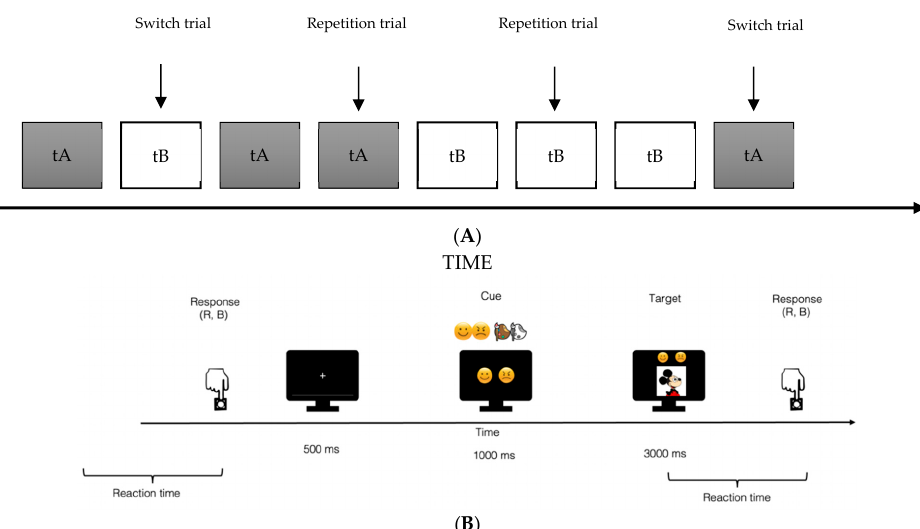
Figure 2. Emotional task-switching ( A ) and timing of events ( B ). tA = Valence task (“it’s happy or angry?”); tB = Color task (“it’s in black & white or coloured?”).